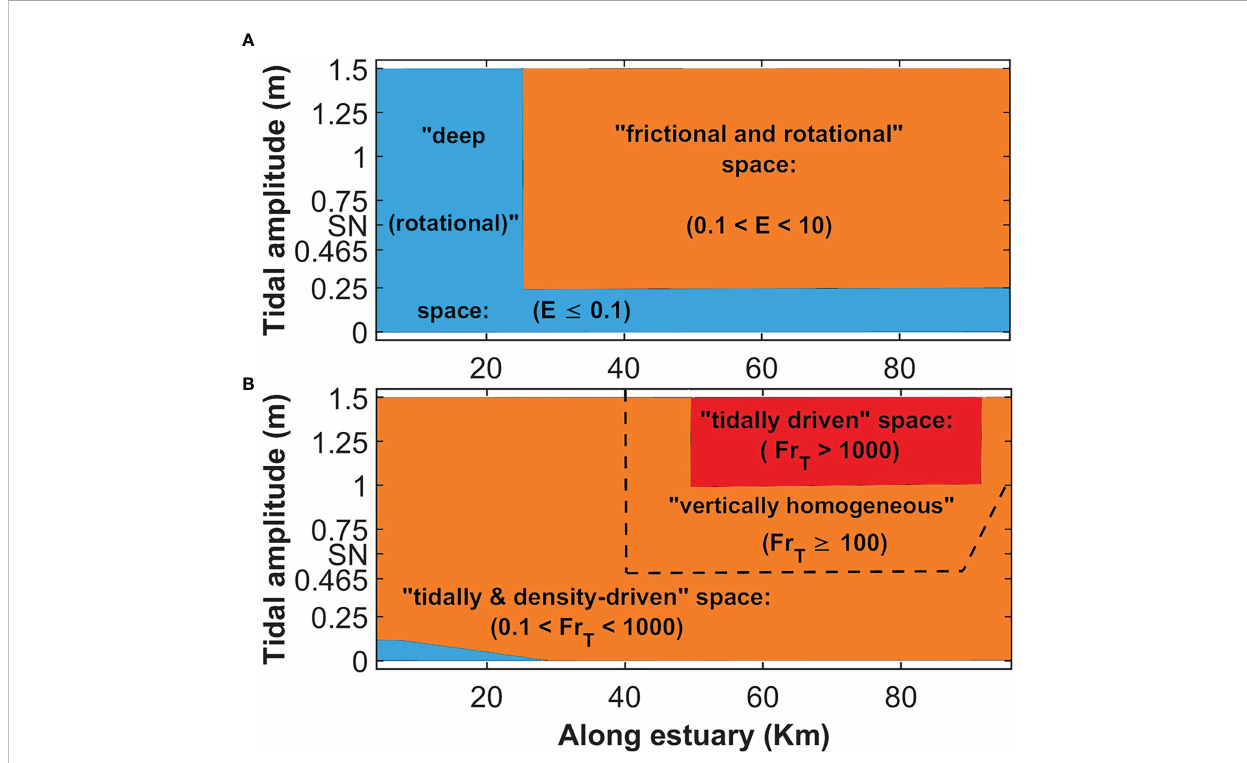
FIGURE 13 The schematic fi gures of the estuarine classi fi cation along the micro- and meso-tidal funnel-shaped salt-plug estuaries according to the longitudinal distributions of their Ekman (A) and tidal Froude numbers (B) . “ SN ” on the y-axis stands for the spring-neap scenario of EXP11. The small blue color close to the estuary mouth (0 km-30 km) in (b) indicates “ density-driven ” space with Fr T ≤